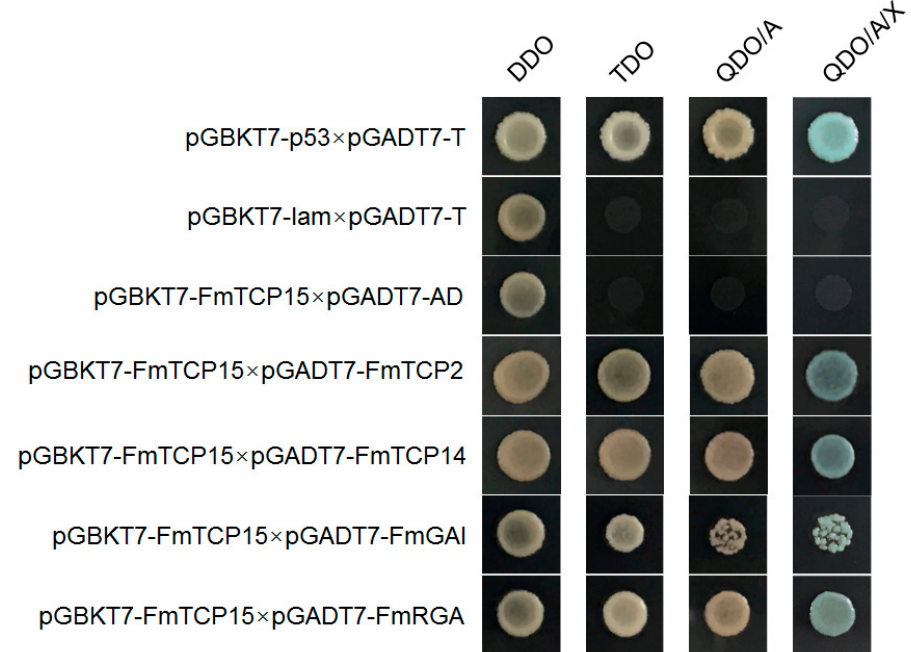
Figure 6. Yeast two-hybrid protein–protein interaction assays between FmTCP15 and DELLA proteins. The coding sequences of FmTCPs , FmRGA , and FmGAI were cloned intopGADT7 (AD) and pGBKT7 (BK) vectors. Transformants were assayed for growth on DDO, TDO, QDO / A, and QDO / A / X nutritional selection medium, and turning blue in the presence X- α -Gal was scored as a positive interaction.